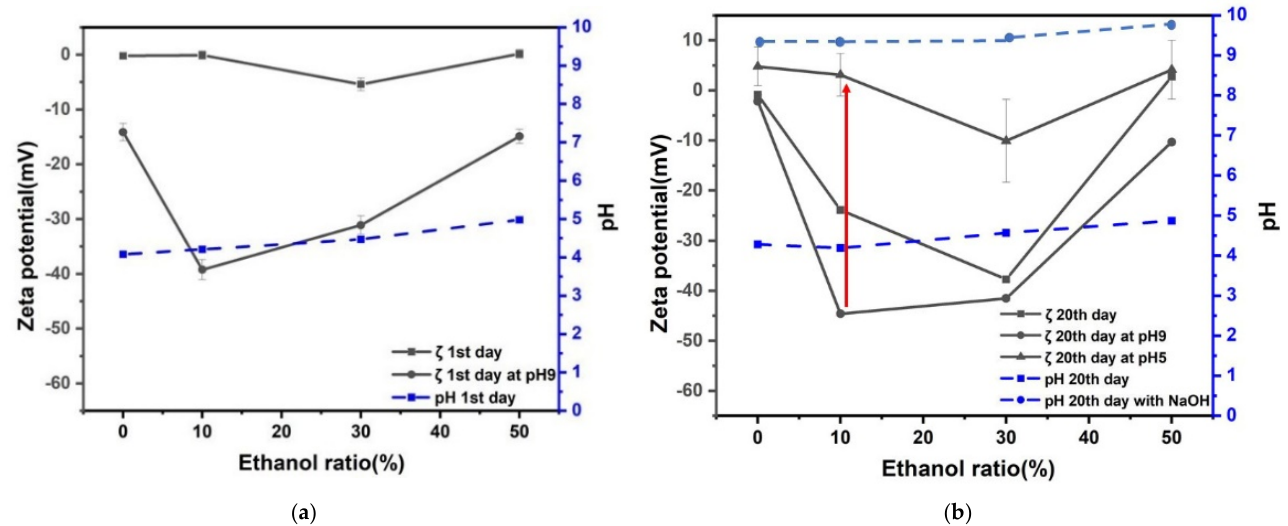
Figure 5. Zeta potential and pH for CO 2 nanobubble solution as a function of ethanol percentage of ethanol aqueous solution mixtures after: ( a ) 1 day and ( b ) 20 days.